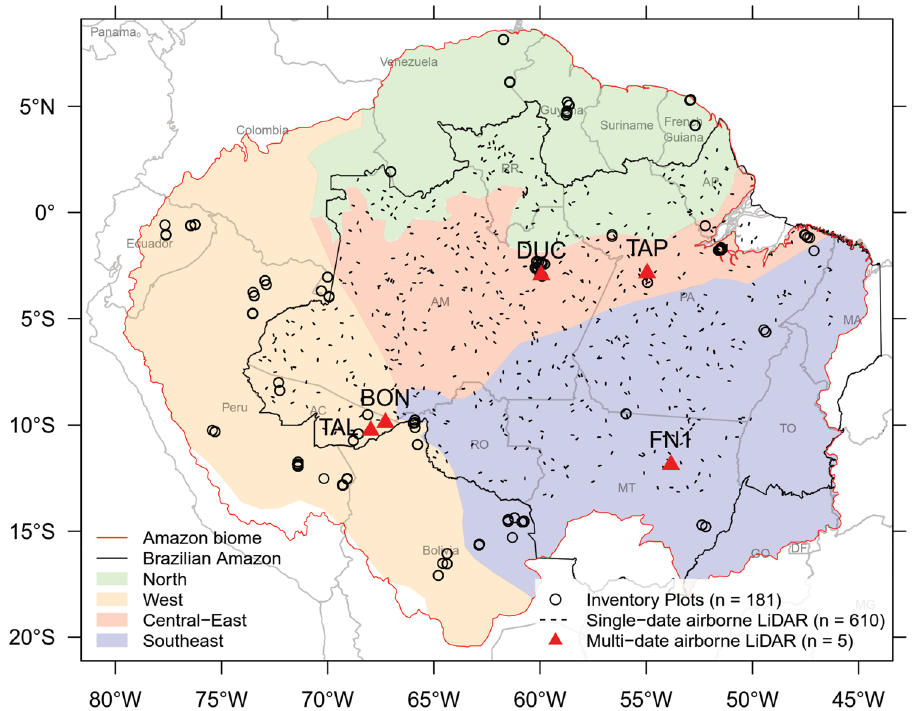
Figure 6. The Amazon in South America with colored regions, defined in Feldpausch et al. 33 , indicating faster (West and Southeast) and slower forest dynamics (Central-East and North). Small black lines represent single- date airborne lidar data acquisitions from the EBA project ( n = 610 flight lines). Red triangles illustrate multi- temporal lidar data acquisition over five sites (BON, DUC, FN1, TAL and TAP). Circles indicate the location of field inventory plots ( n = 181). R v4.0.2 was used to plot this figure 32